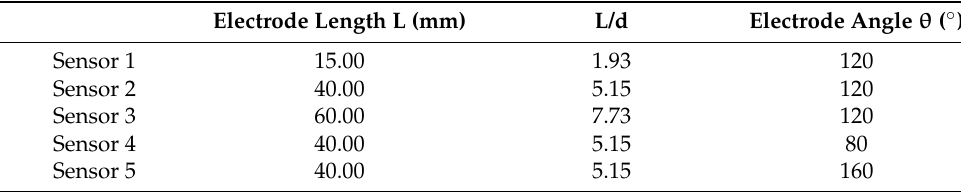
Table 2. The geometry parameters of all the C 4 D